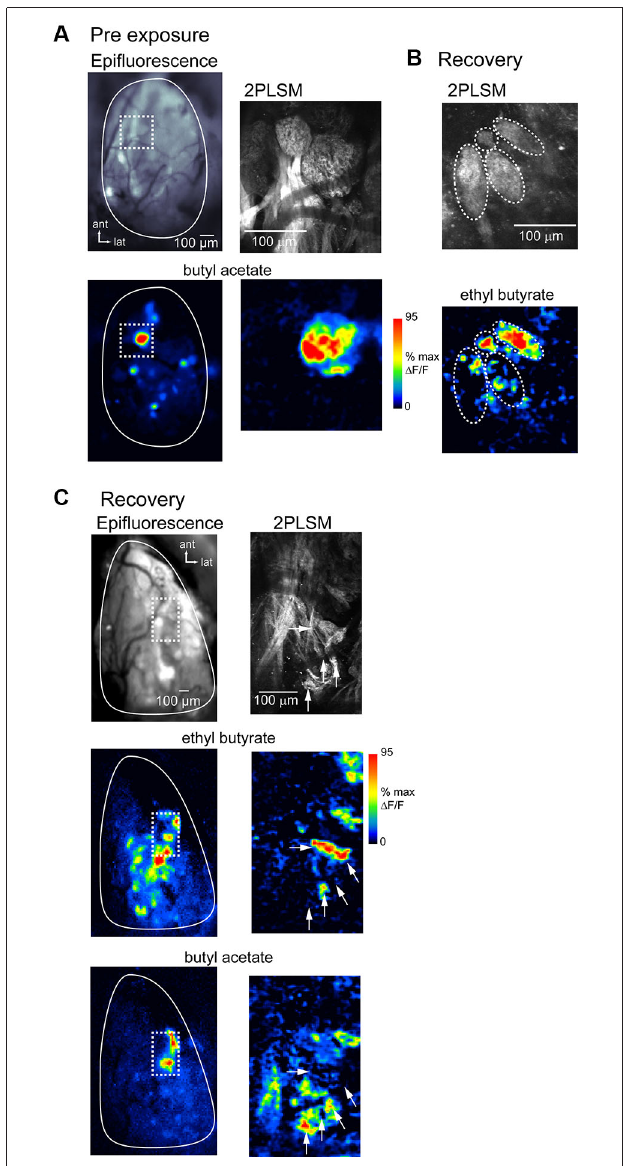
FIGURE 7 | Atypical glomerular convergence of OSNs confirmed with in vivo two-photon imaging of spH signals. (A) Resting fluorescence and evoked spH response maps imaged with wide-field epifluorescence ( left ) and 2-photon laser scanning microscopy (2PLSM; right ) in the same unlesioned animal. Epifluorescence image taken with 4x objective. Odorant, butyl acetate. Dashed box indicates area imaged at higher-magnification with 2PLSM. With 2PLSM, spH fluorescence increases are apparent throughout the glomerulus, with “hot-spots” of high signal amplitude in subglomerular regions. (B) 2PLSM resting fluorescence ( top ) and response map ( bottom ) from a lesion-recovered animal. Glomerular boundaries are less well-defined (compare to (A) ); in this example several relatively discrete structures are apparent (indicated by dashed ovals), one of which is only 30–40 µ m in diameter ( top ). Response map ( bottom ) shows spH signals with approximate boundaries of the four structures overlaid. In two of these structures, odorant (ethyl butyrate, 5% s.v.) only evokes signals in a few foci, with the rest of the area showing no